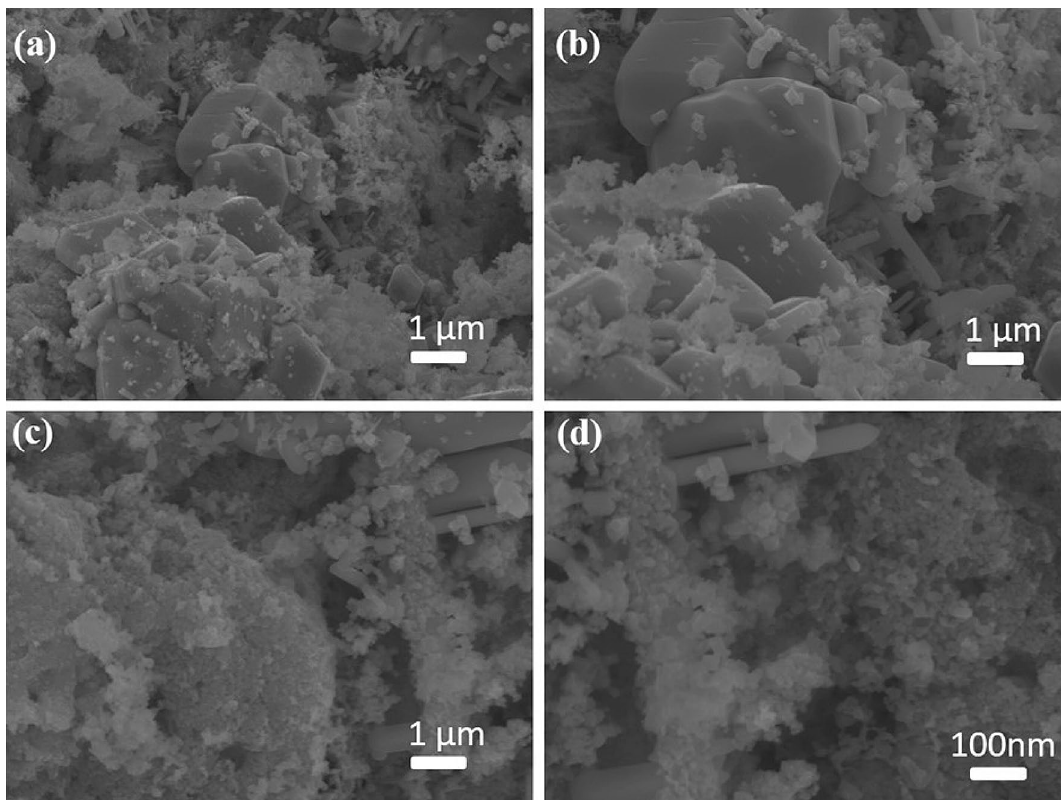
Figure 3. ( a–d ) SEM morphology of the CuO@MnO 2